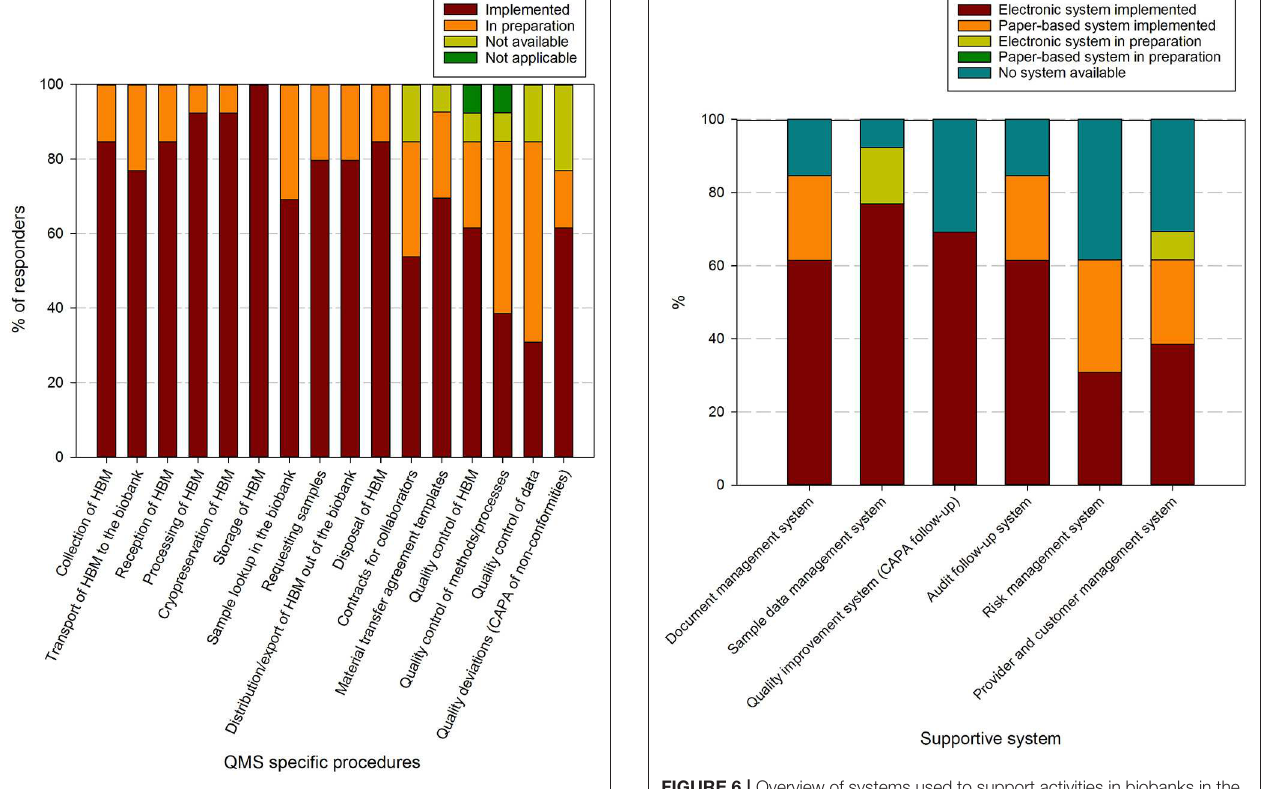
systems are the least available. Predominantly electronic/digital